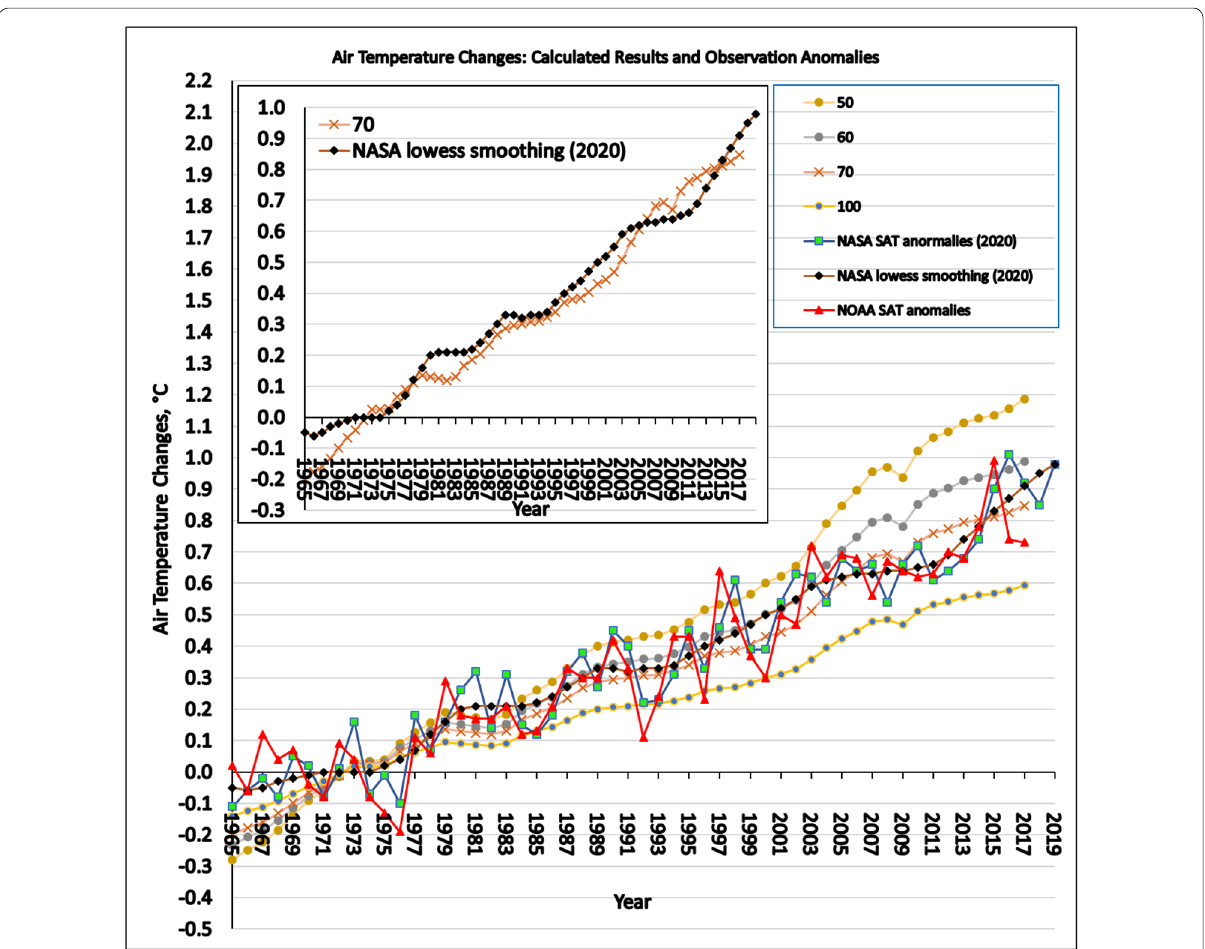
Fig. 2 Simulation of global surface air temperature changes in an air boundary layer at different depths between 1965 and 2017, and NASA, NOAA’s surface air temperature anomalies (SAT), NASA’s Lowess Smoothing trend